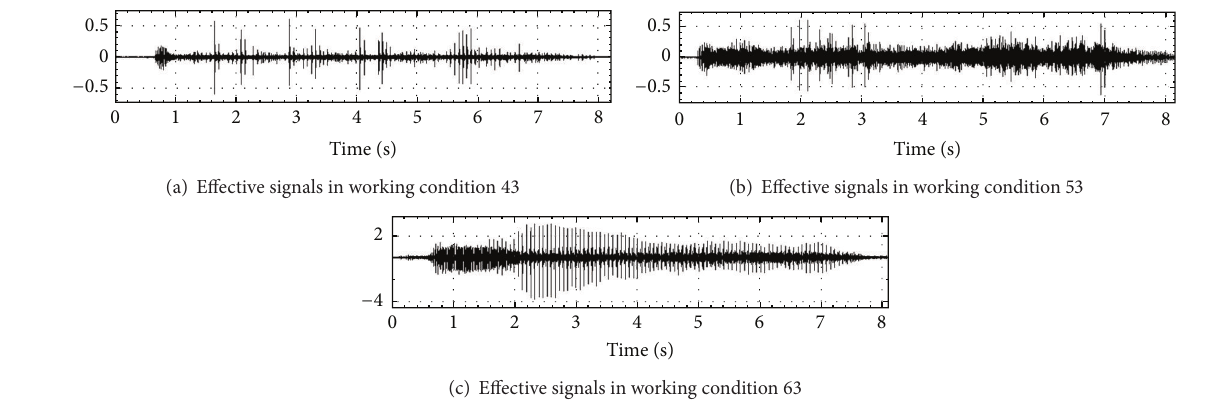
Figure 37: Effective microseism signals in certain working